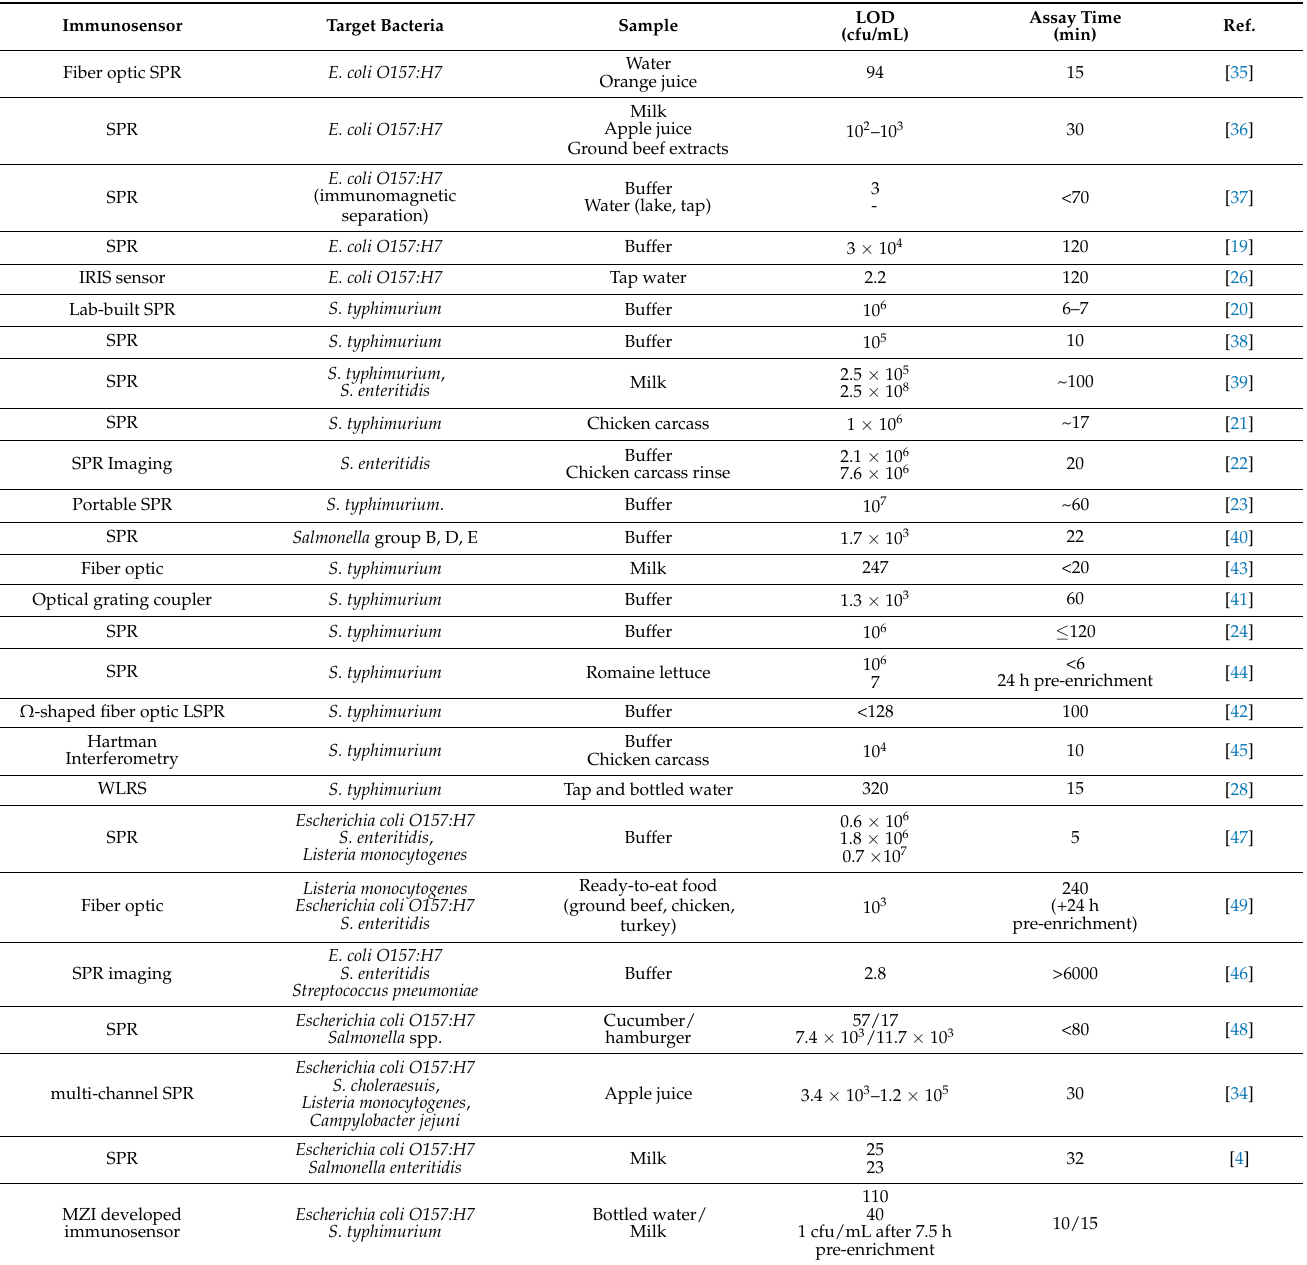
Table 1. Comparison of the proposed MZI immunosensor with other optical label-free